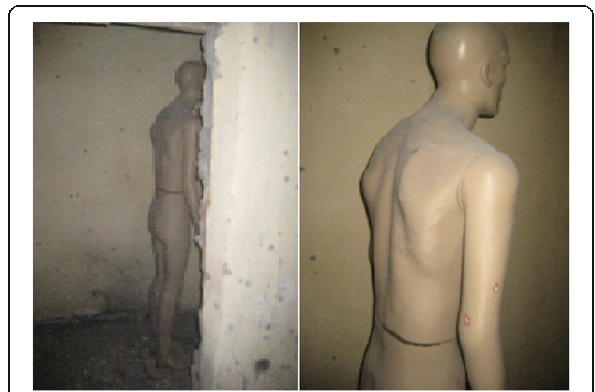
Fig. 16 Mannequin-1 (male-1) positioned face to the corridor door after